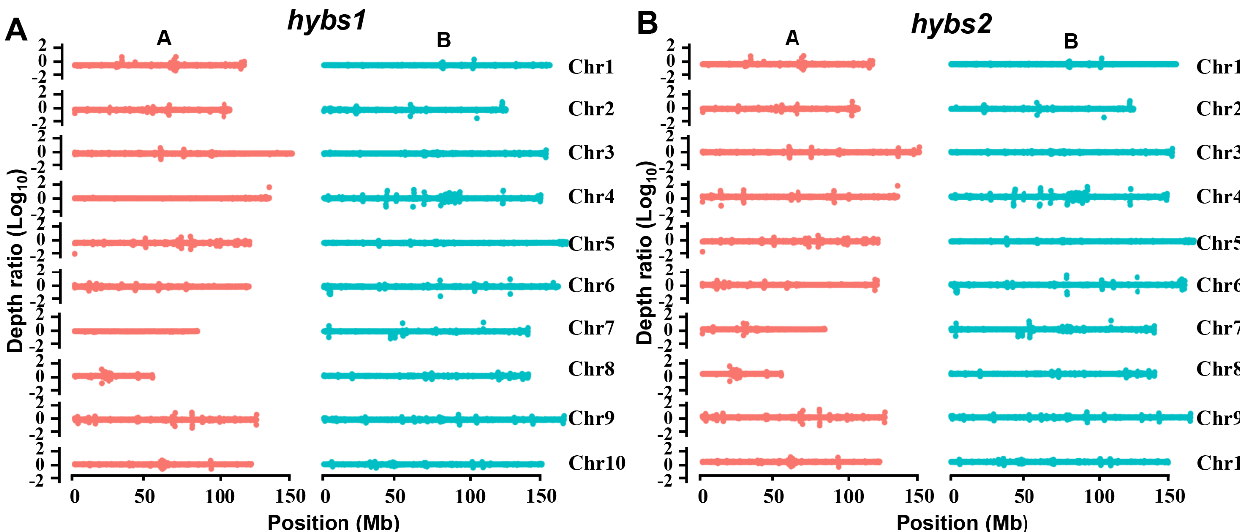
Figure 2. Depth − of − coverage of sequence reads from WT, hybs1 , and hybs2 along the chromosomes. ( A , B ) Distribution of the sliding window average of depth ratio in hybs1 ( A ) and hybs2 ( B ). The window size was 100 kb. The depth ratio was calculated by dividing the depth − of − coverage of mutant by the depth − of − coverage of WT; the ratio was then log 10 transformed. Red: A subgenome; Skyblue: B subgenome.